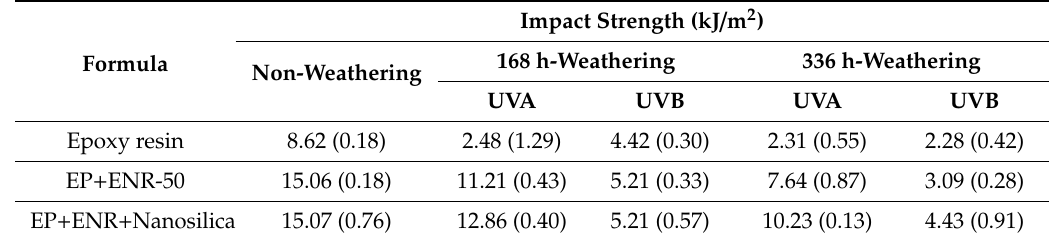
Table 2. The mean values of the impact strength of the samples.